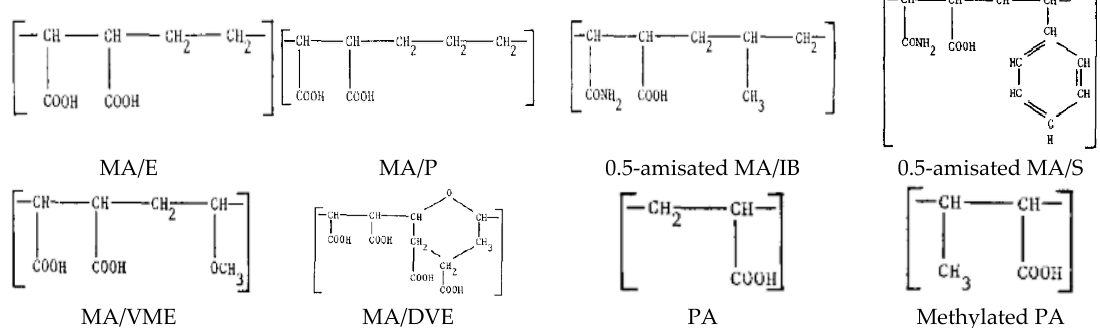
Figure 12. The commercial polymers used by Finkelstein and Merigan. MA—maleic